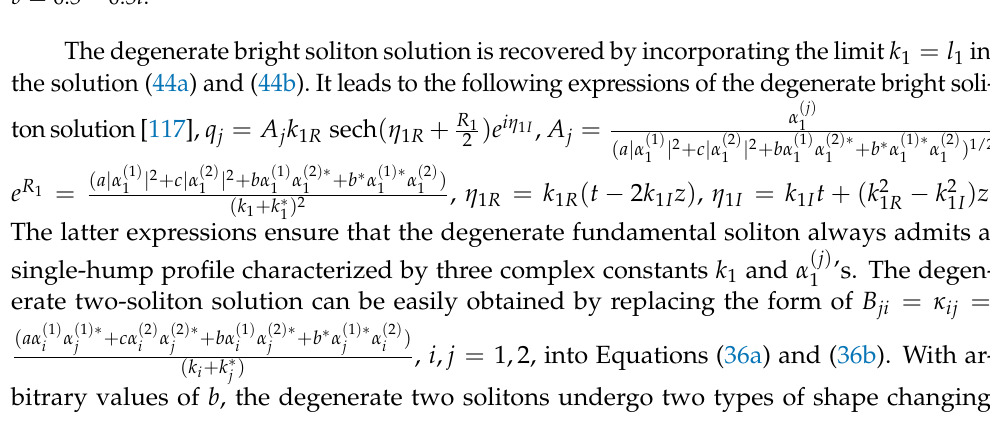
( 1 ) = 0.35 + 0.35 + i , α ( 2 ) = 0.5 + 0.5 i , a = c = 1 and 1 1